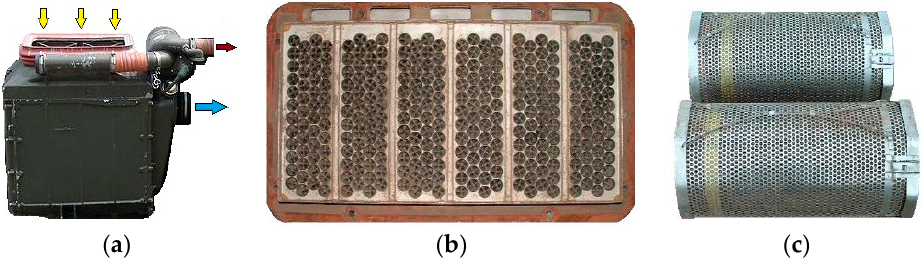
Figure 1. Two-stage (multi-cyclone-porous partition) air filter in Leopard 2 tank: ( a ) filter view, ( b ) multi-cyclone—cyclone inlets, ( c ) filter cartridges.